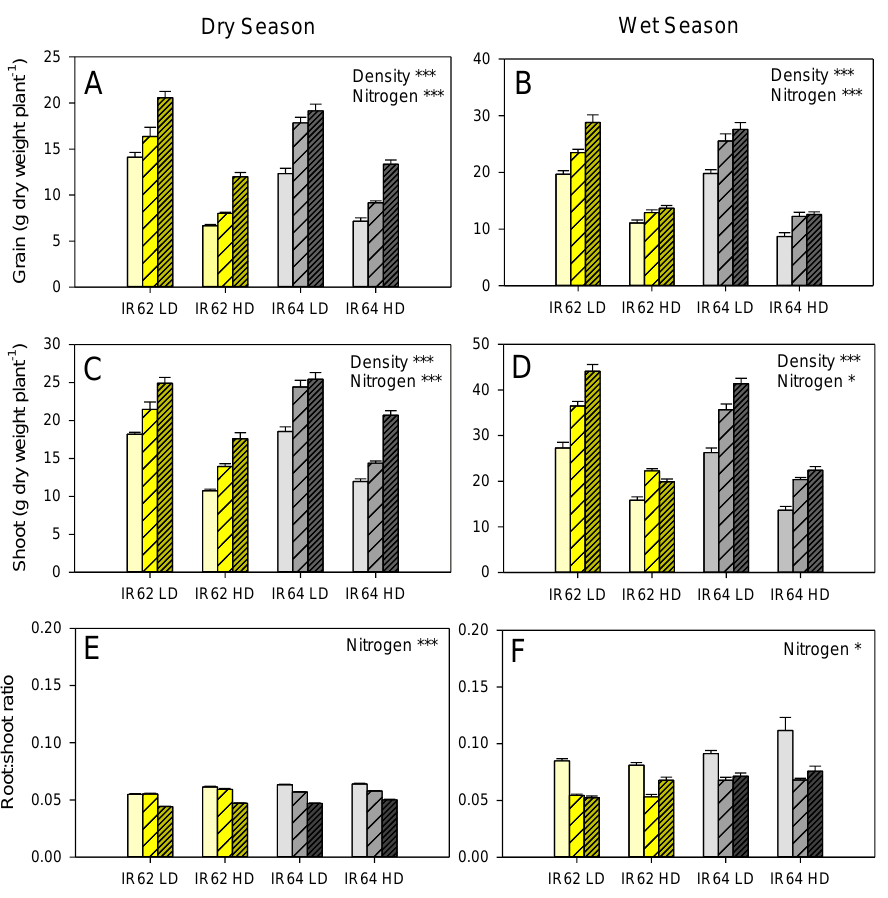
Figure 9. The weight of filled grain ( A , B ), weight of non-reproductive plant parts ( C , D ) and root: shoot ratios ( E , F ) of R62 (yellow bars) and IR64 (grey bars) transplanted at low (LD) and high (HD) densities under varying nitrogen fertilizer treatments. Nitrogen was applied at 0 Kg ha − 1 (open bars), 60 Kg ha − 1 (hatched bars) and 150 Kg ha − 1 (densely-hatched bars). Factors that significantly affected each parameter are presented with significance levels as * p ≤ 0.05 and *** p ≤ 0.005. Plants were evaluated at harvest time for dry ( A , C , E ) and wet ( B , D , F ) season crops. Standard errors are indicated ( N = 6). The same data, together with other growth parameters are presented in Table S3. Final yields per m 2 were not different between varieties and were not affected by transplanting density in either season (Table 2). Yields increased linearly with increasing nitrogen in both seasons (linear contrasts, p < 0.001) (Table 2). IR62 plants, and plants in low-density plots had more unfilled grain per square m than IR64 or plants in high-den- sity plots respectively, but only during the DS (Table 2). A higher proportion of IR62 grain